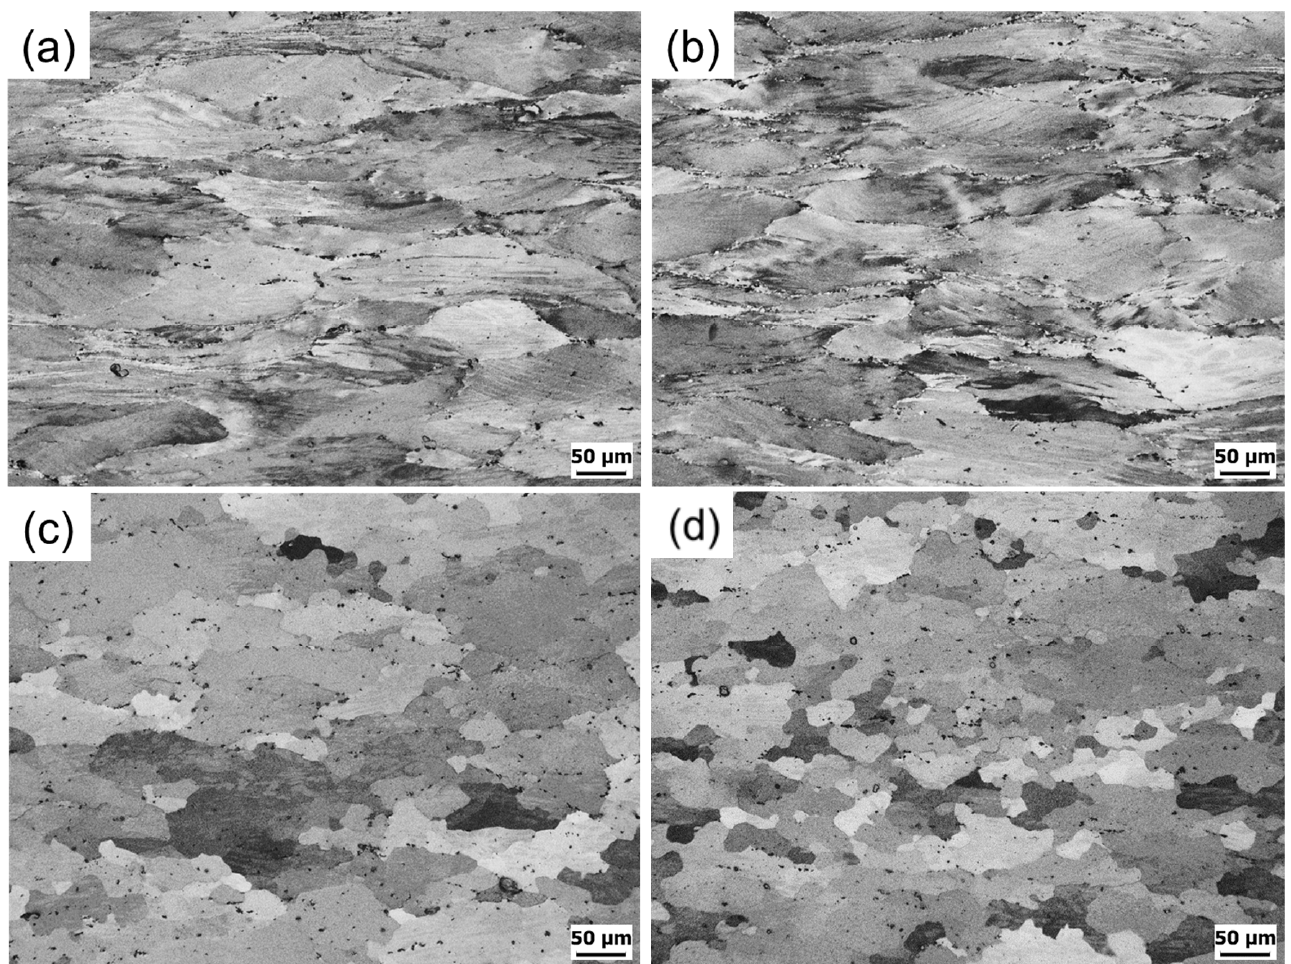
Figure 4. Optical micrographs of the as hot compressed microstructures in the ( a ) Al-6Mg and ( b ) Al-8Mg of 300 ◦ C–10 0 /s and ( c ) Al-6Mg and ( d ) Al-8Mg of 400 ◦ C–10 − 3 /s at a strain of